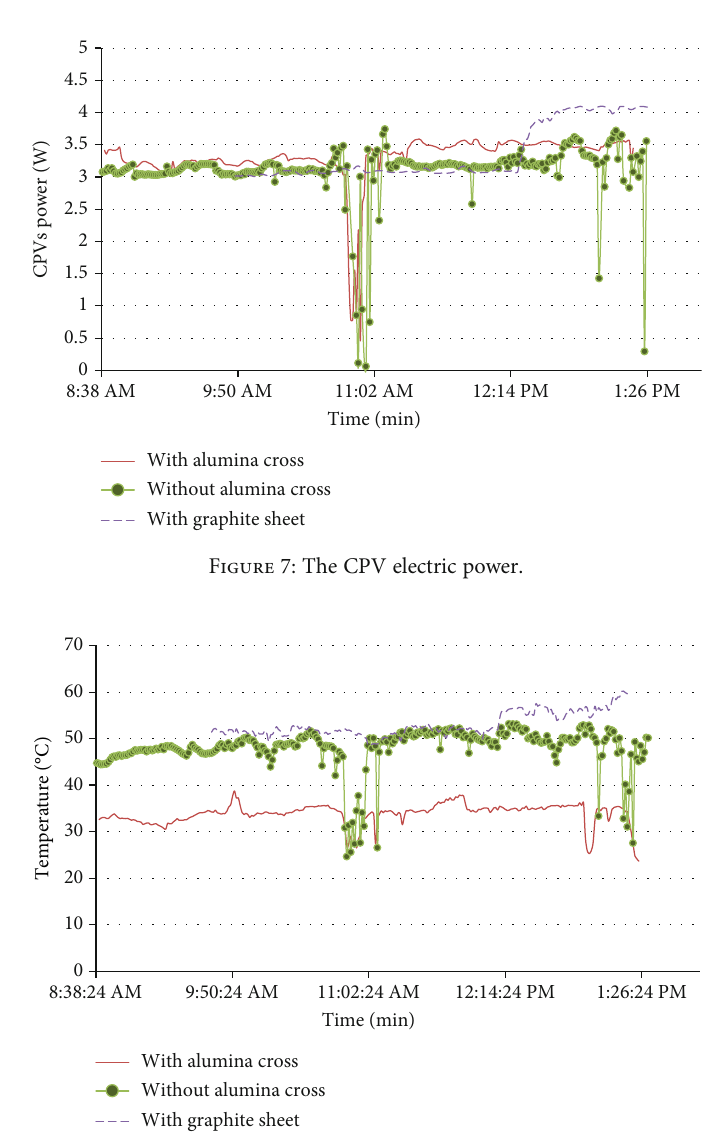
Figure 8: The CPV